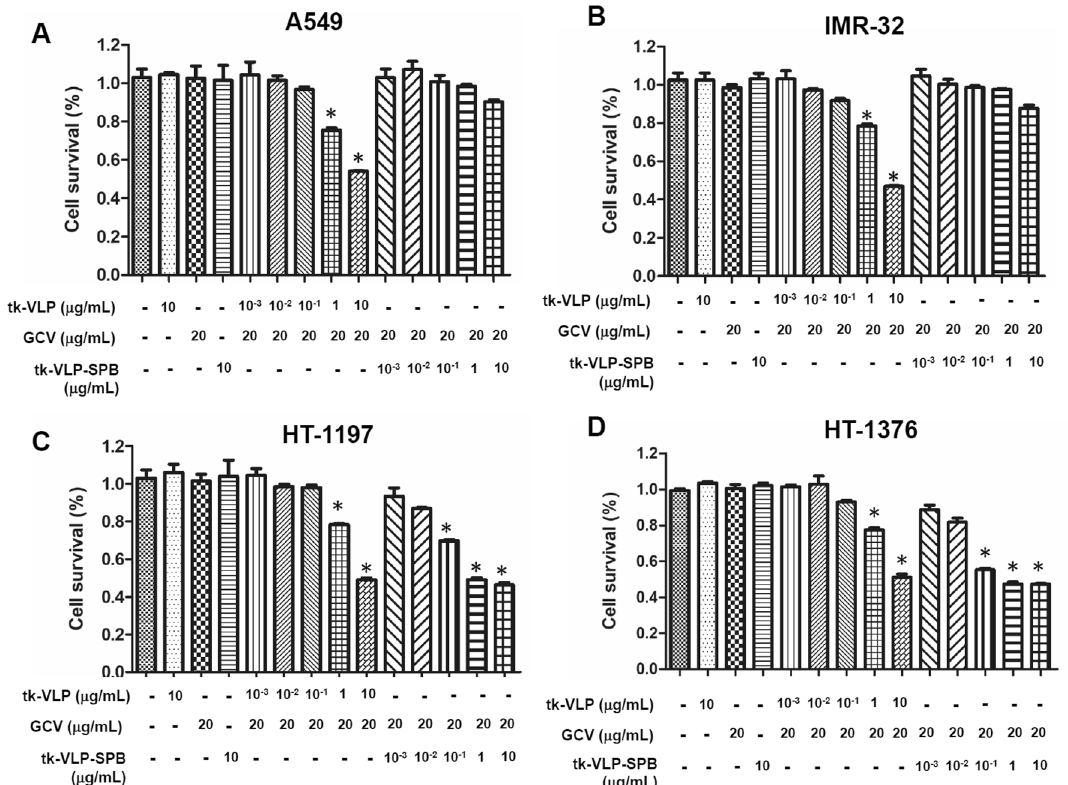
Figure 4. Determination of the specific cytotoxicity of tk-JCPyV VLP-SPBs. Specific cytotoxicity of tk-JCPyV VLP-SPBs to ( A ) A549 lung cancer cells, ( B ) IMR-32 neuroblastoma cells, ( C ) HT-1197 bladder cancer cells and ( D ) HT-1376 bladder cancer cells treated with different concentrations (0.001, 0.01, 0.1, 1, and 10 µg/mL) of tk-JCPyV VLPs or tk-JCPyV VLP-SPBs in the presence of 20 µg/mL ganciclovir (GCV). Cell viability